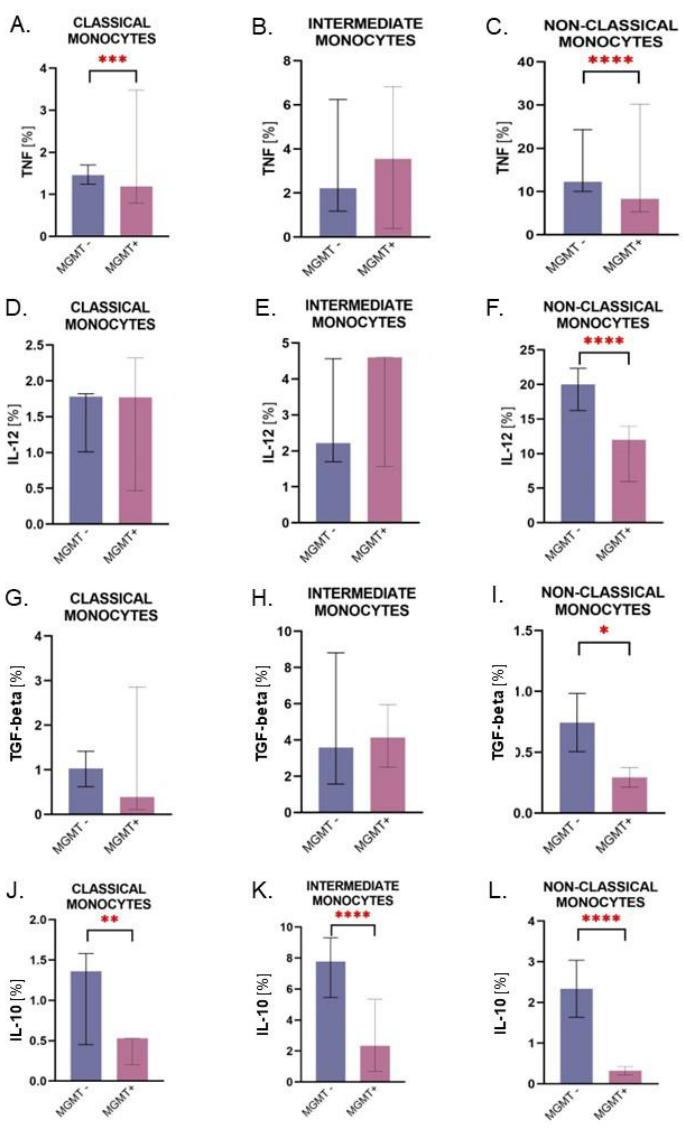
Figure 6. The figure shows differences between monocyte subpopulations’ cytokine expression in the context of MGMT gene promoter methylation status. Graphs ( A – F ) focus on pro-inflammatory molecules (TNF, IL-12), though graphs ( G – L ) visually present data on anti-inflammatory cytokines (TGF-beta, IL-10). ‘ MGMT - ‘ stands for MGMT -unmethylated tumor status, ‘ MGMT + ’ stands for MGMT -methylated tumor status; * p < 0.05, ** p < 0.01, *** p < 0.001, **** p < 0.0001.